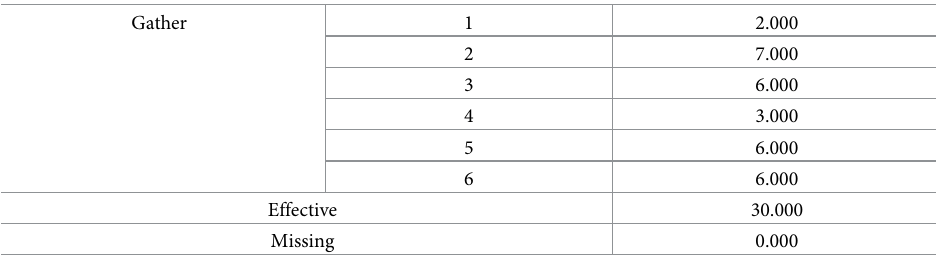
Table 5. Number of observations in each cluster.